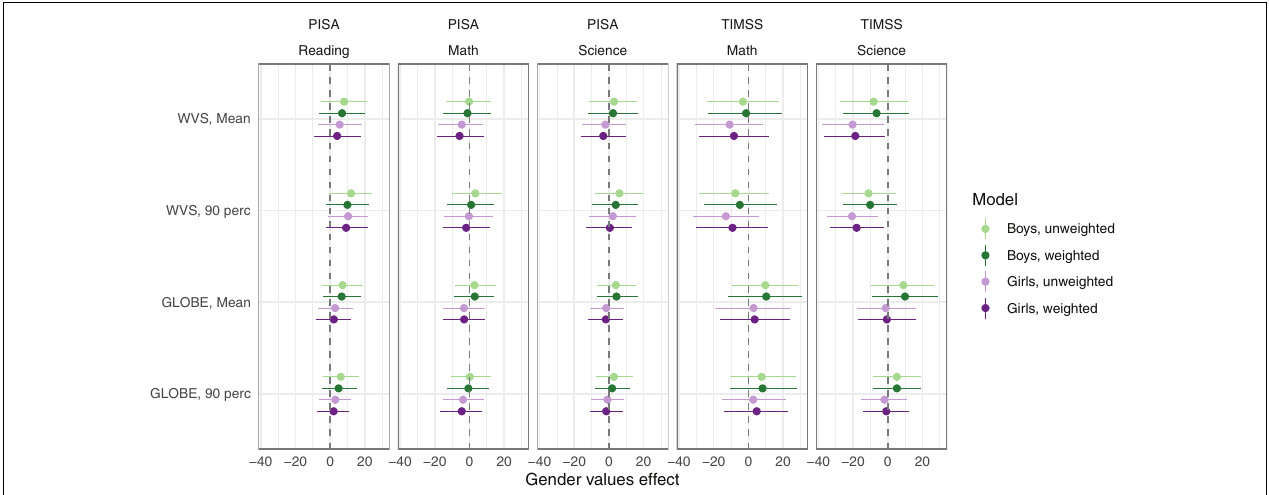
FIGURE 1 | Estimated effects of gender egalitarian values on the mean and 90th percentile achievement of boys and girls. Note . The figure shows fixed effects of gender egalitarian values on the mean and 90th percentile of boys’ (green) and girls’ (violet) achievement, with bootstrapped 95% CI for weighted (dark) and unweighted (light) models. At the country level, all models included random intercepts. Entries estimate the number of points by which achievement scores increase when the gender egalitarian values increase by one standard deviation, holding all covariates constant. Different analyses are based on data from different samples of countries: 56 countries had both PISA and WVS data (total number of observations: n = 242 for reading, n = 213 for math, n = 186 for science), 40 countries had both PISA and GLOBE data ( n = 203 for reading, n = 175 for math, n = 147 for science), 49 countries had both TIMSS and WVS data ( n = 129), and 32 countries had both TIMSS and GLOBE data ( n = 90). Standard deviations for the country random intercept ranged between 23.0 and 52.7 (mean = 36.8), and for residuals between 10.1 and 22.3 (mean = 14.7). The average marginal R squared was 0.55 (SD = 0.09, min = 0.38, max = 0.73).